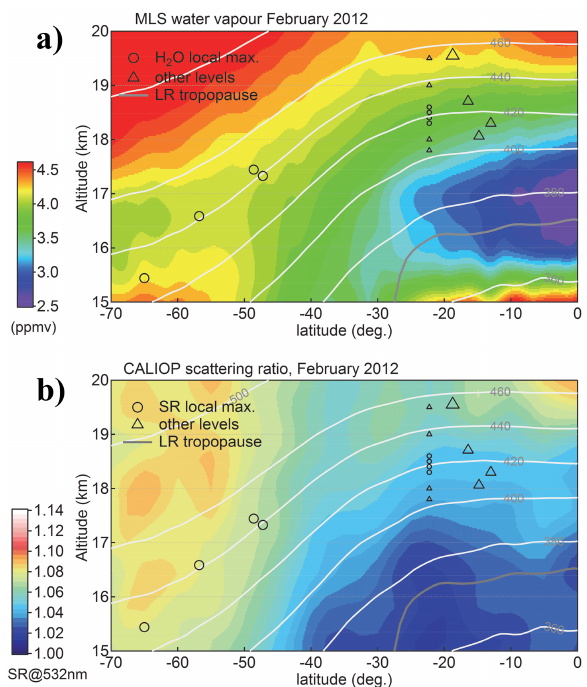
Figure 2. Latitude–altitude section of monthly zonal mean MLS water vapour (a) and CALIPSO scattering ratio (b) . Larger mark- ers (circles and triangles) indicate the location of the sampled air masses 15 days prior to balloon sounding on 13 March (same convention as in Fig. 1) Smaller markers indicate the locations where trajectories were initialised. Circles denote the trajectories initialised from the WV/SR enhancement; triangles denote trajecto- ries initialised at levels below and above. The isentropes (white con- tours) and the lapse rate (LR) tropopause (grey curve) were calcu- lated using zonally averaged COSMIC GPS radio-occultation mea- surements (Anthes et al.,